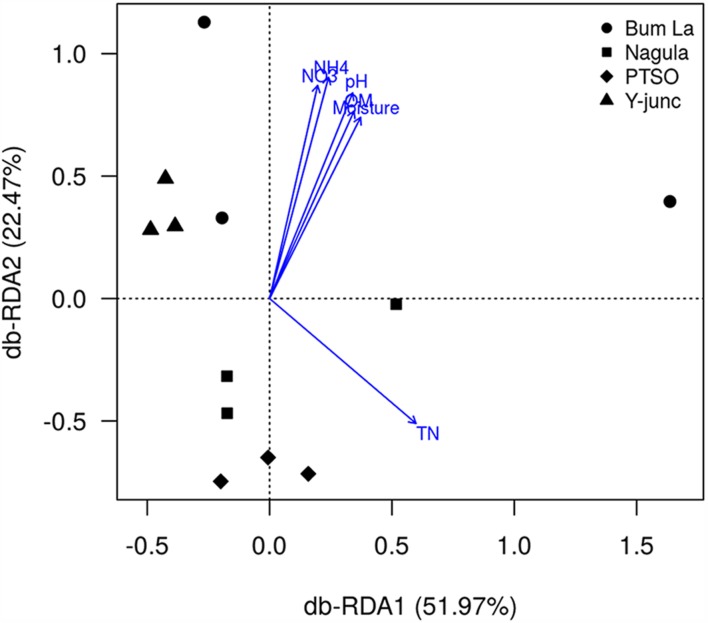
Redundancy analysis of the effect of discriminative soil parameters on bacterial communities. Numbers in parenthesis indicate the percentage of total variation explained by each axis. Only soil parameters which significantly (p < 0.05 by 1000 permutation tests) explained the bacterial community variation are shown.